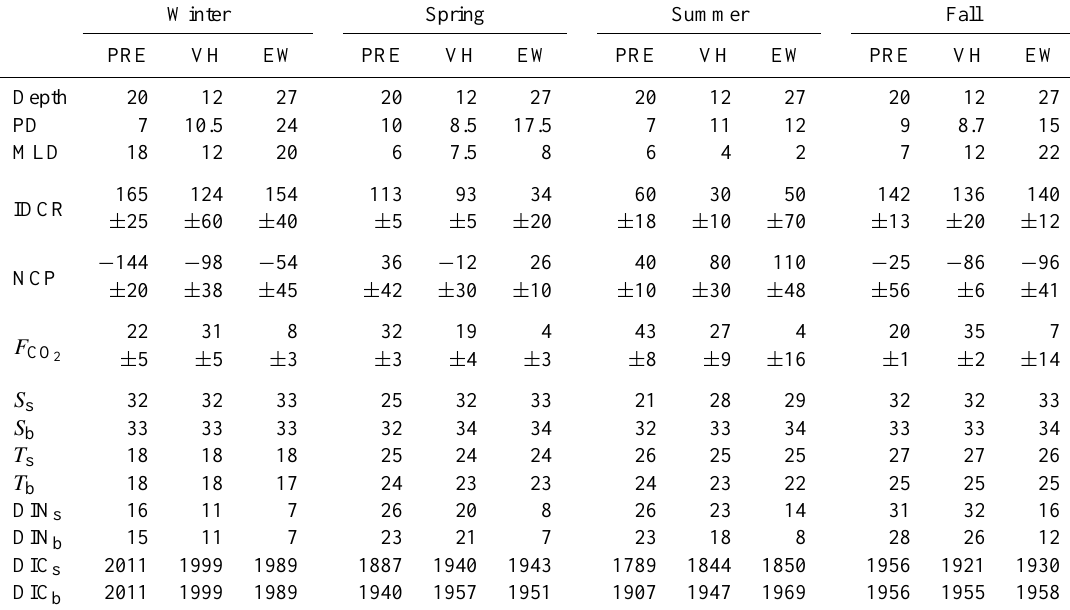
Table 1. Seasonal variations in depth (m), photic depth (1% light depth) (PD, m), mixing layer depth (MLD, m), integrated dark community in the mixed layer, surface and bottom salinity ( S s and S b ), temperature ( T s and T b , ◦ C), dissolved inorganic nitrogen (DIN s and DIN b , µM) and dissolved inorganic carbon (DIC s and DIC b , µM) near the Pearl River estuary (PRE), Victoria Harbour (VH) and eastern waters (EW) (see Fig. 1 for locations). ± 1SD and n = 2 to